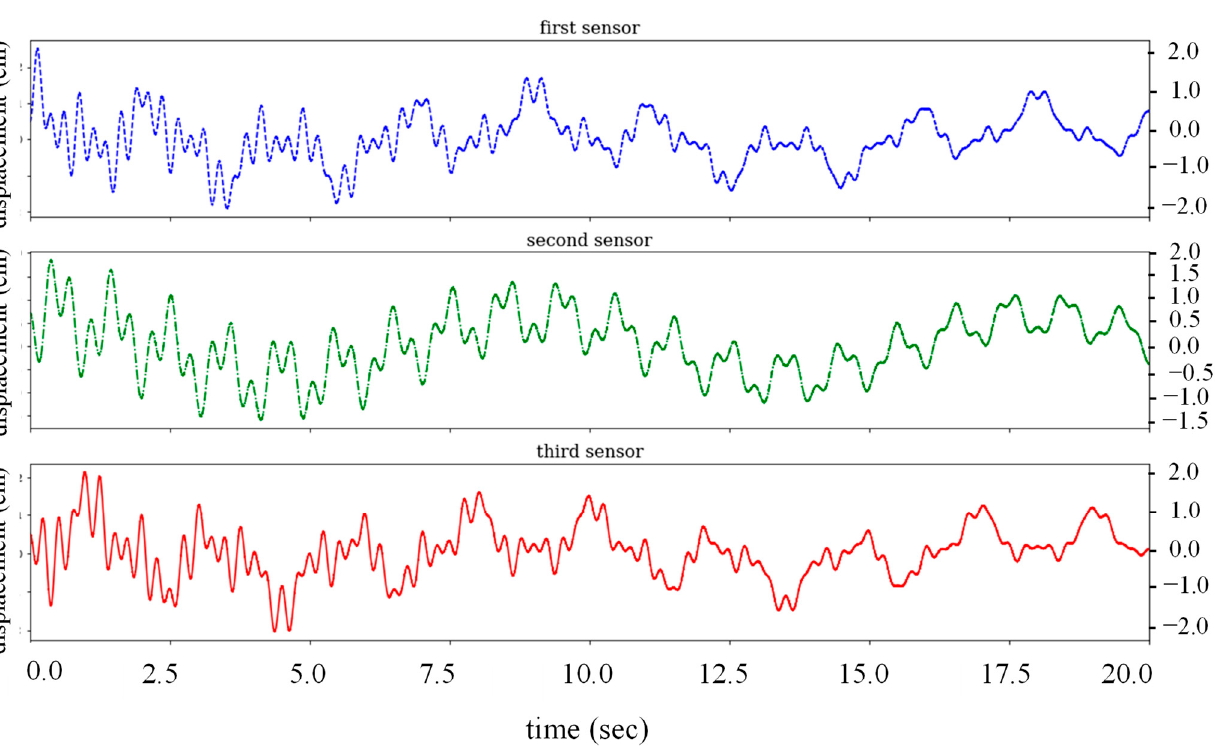
Figure 20. Sensor outputs of the beam.